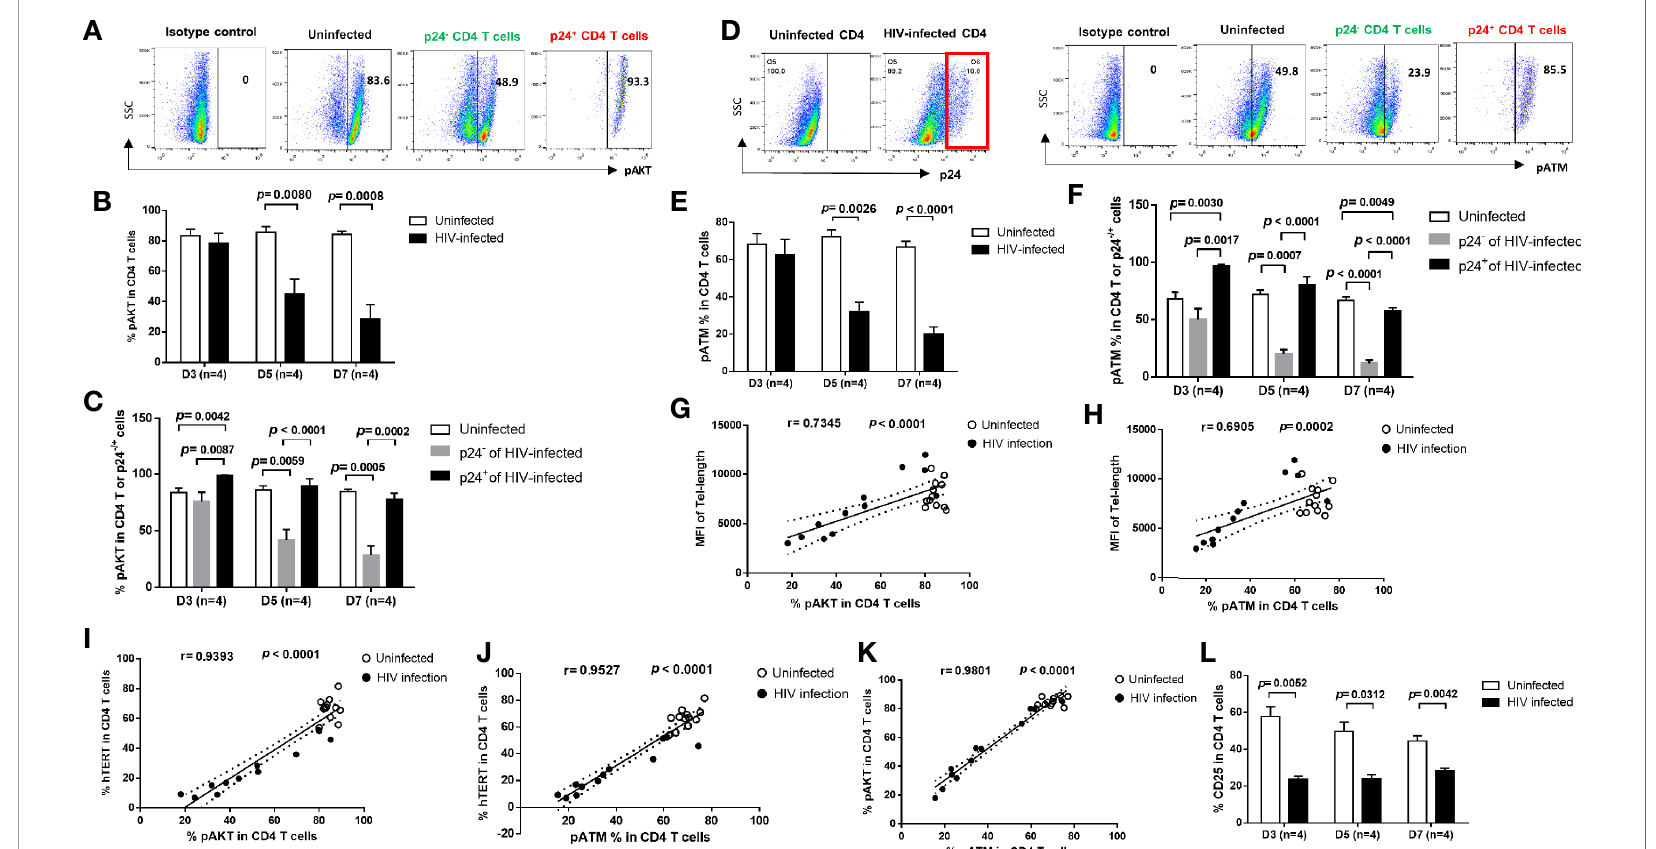
FIGURE 4 | T cell receptor (TCR) signaling pathways are differentially regulated in productively HIV-infected and bystander cells. (A – C) Representative dot plots and summary data of the pAKT % in HIV-infected (p24 + ) and bystander (p24 - ) or uninfected D4 T cells at days 3, 5, and 7. (D – F) Representative dot blots and summary data of the pATM % in HIV-infected (p24 + and bystander (p24 - ) or uninfected CD4 T cells at days 3, 5, and 7, by fl ow cytometry. (G, H) Positive correlation between the MFI of telomere length and the % of pAKT or pATM expressions. (I – K) Positive correlation between the % of hTERT, pAKT, and pATM expressions in CD4 T cells with or without HIV infection. (L) Percentage of CD25 expression in CD4 T cells with or without HIV